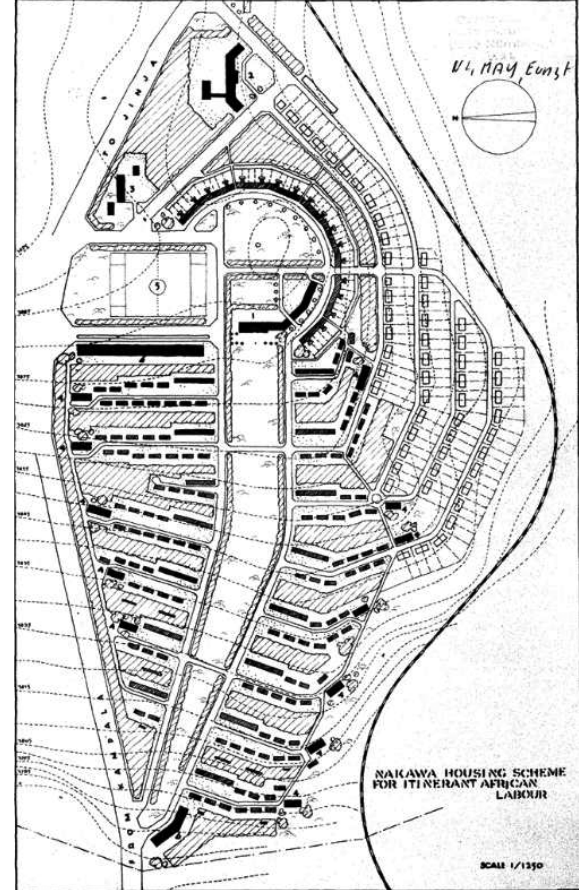
Figure 14. Nakawa Housing Scheme for Itinerant African Labour. Source: Herrel